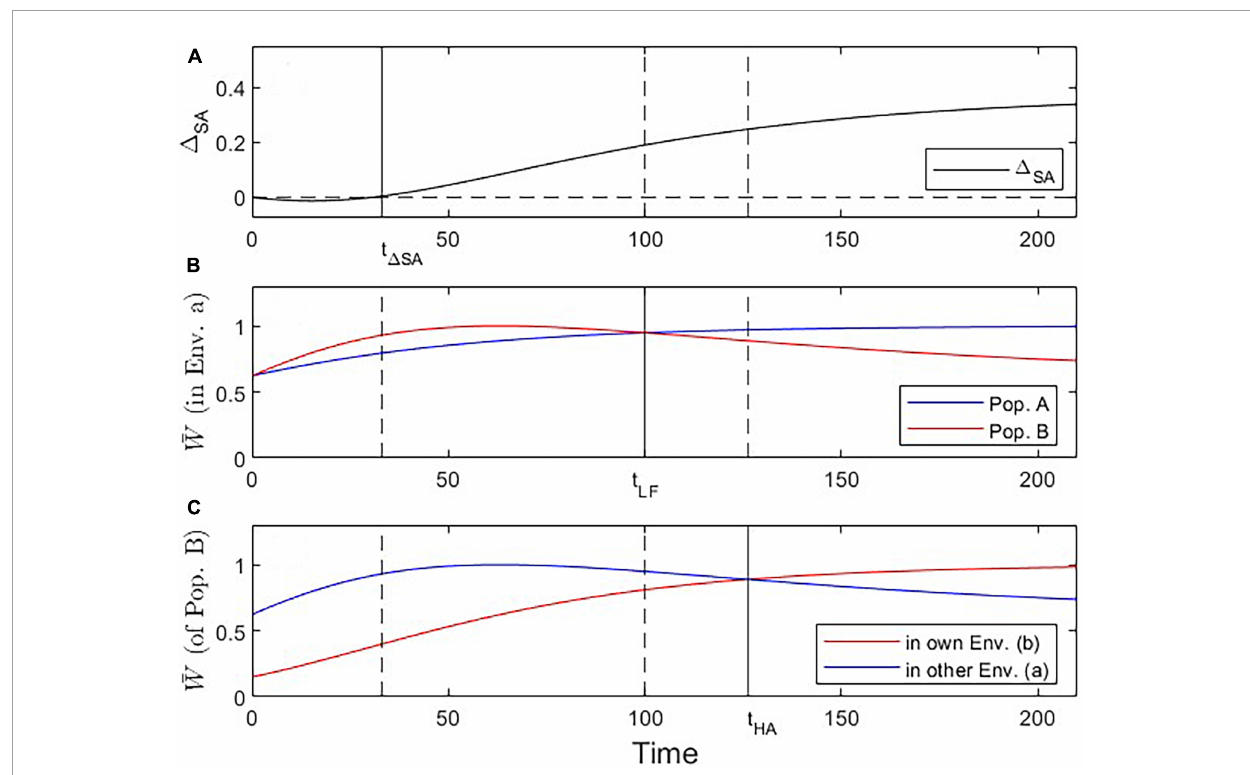
FIGURE4 Visualization of three critical checkpoints (vertical lines) during the evolutionary dynamics under Scenario 2. (A) Evidence for adaptation by the (cid:49) SA contrast criterion (at t ≥ 33). (B) Fitness of population A vs. B in environment a (addressing the Local vs. Foreign criterion; t crit = 100). (C) Fitness of Population B in own vs. other environment (addressing the Home vs. Away criterion; t crit =